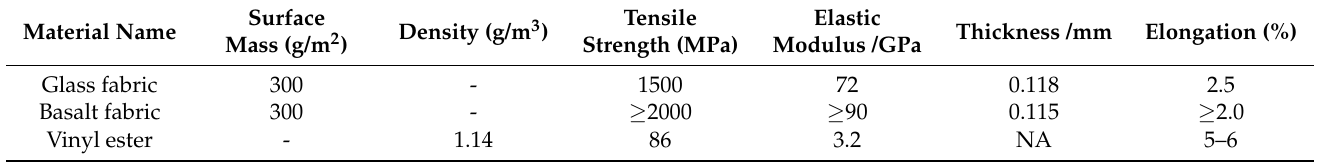
Table 2. Material specifications provided by the